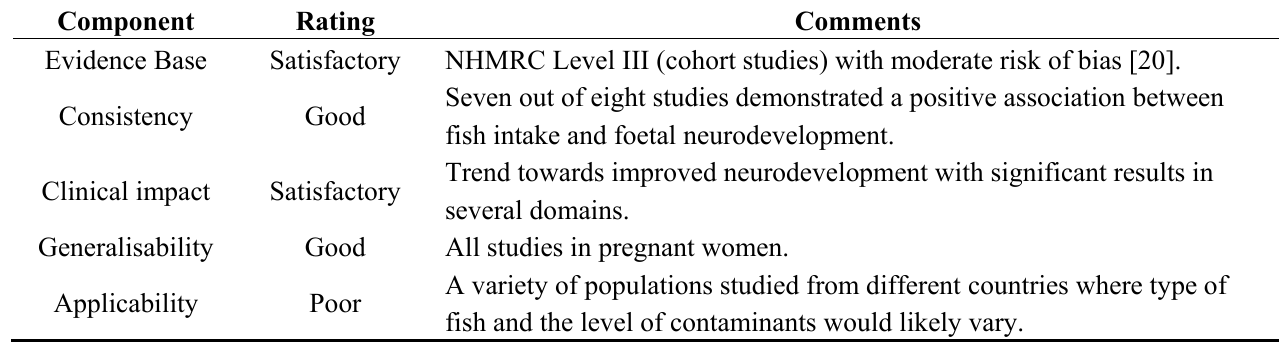
Table 3. Evidence Rating Table